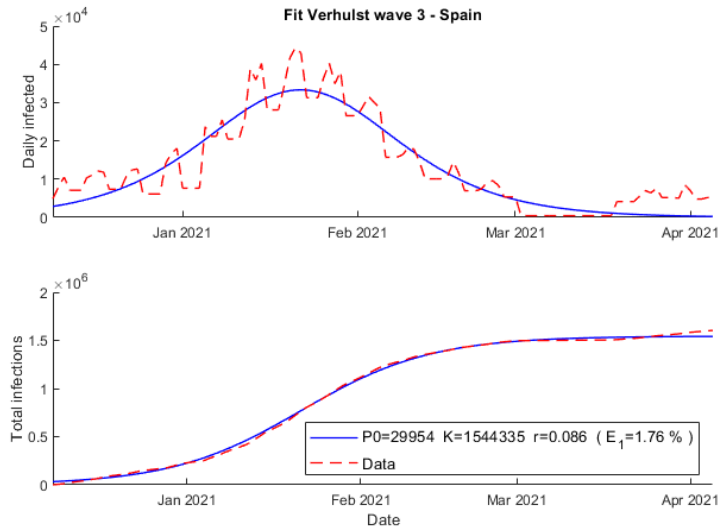
Figure 4. Fit using Verhulst model wave 3 COVID-19 Spain.